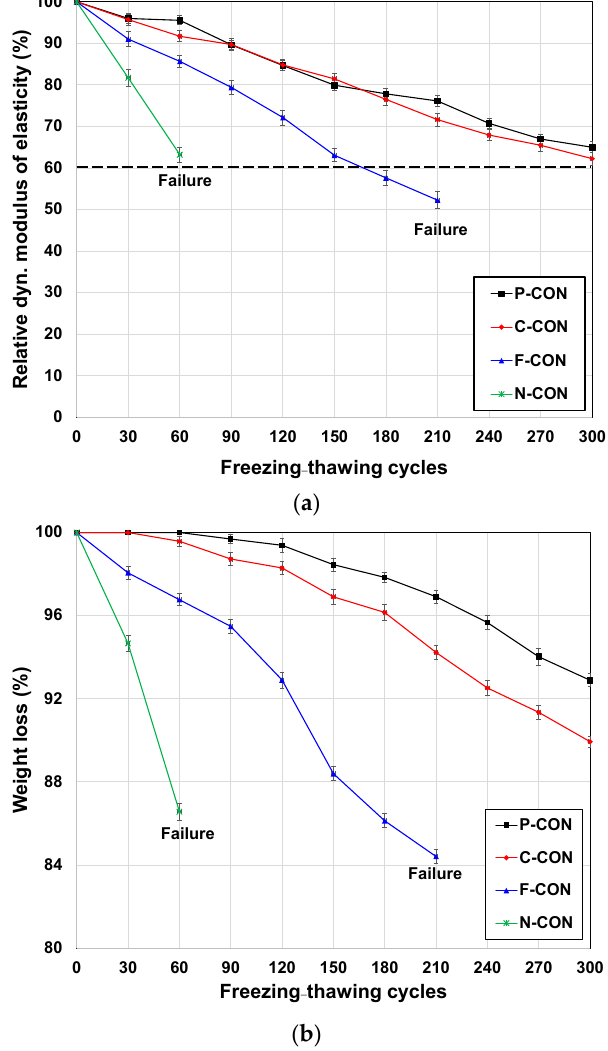
Figure 6. Freezing and thawing test results: ( a ) relative dynamic modulus of elasticity and ( b ) weight loss.